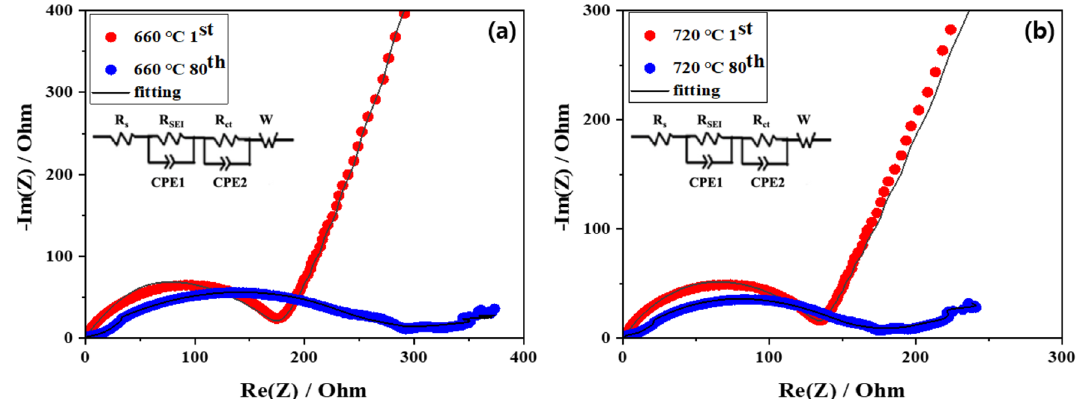
Figure 6. Nyquist plots of NCA sintered at ( a ) 660 °C and ( b ) 720 °C. 660